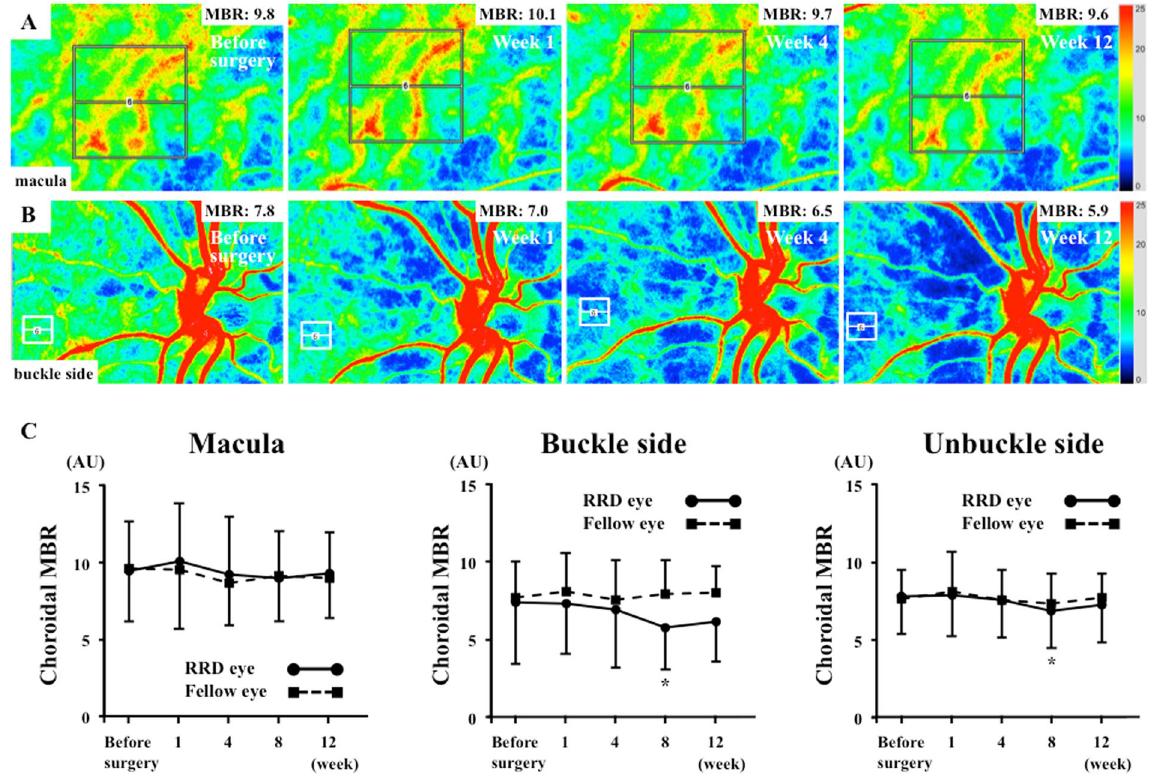
Figure 1. Representative composite colour maps using the mean blur rate (MBR) as measured by laser speckle flowgraphy (LSFG) in eyes with rhegmatogenous retinal detachment (RRD) preoperatively and 1, 4 and 12 weeks postoperatively at the macula ( A ) and the buckle side ( B ). The red colour indicates a high MBR, and the blue colour indicates a low MBR. To measure choroidal MBR, the centre of a square was set at the fovea (250 × 250 pixels, degree: 6.31° × 6.31°) and the buckle and unbuckle side (60 × 60 pixels, degree: 1.5° ×